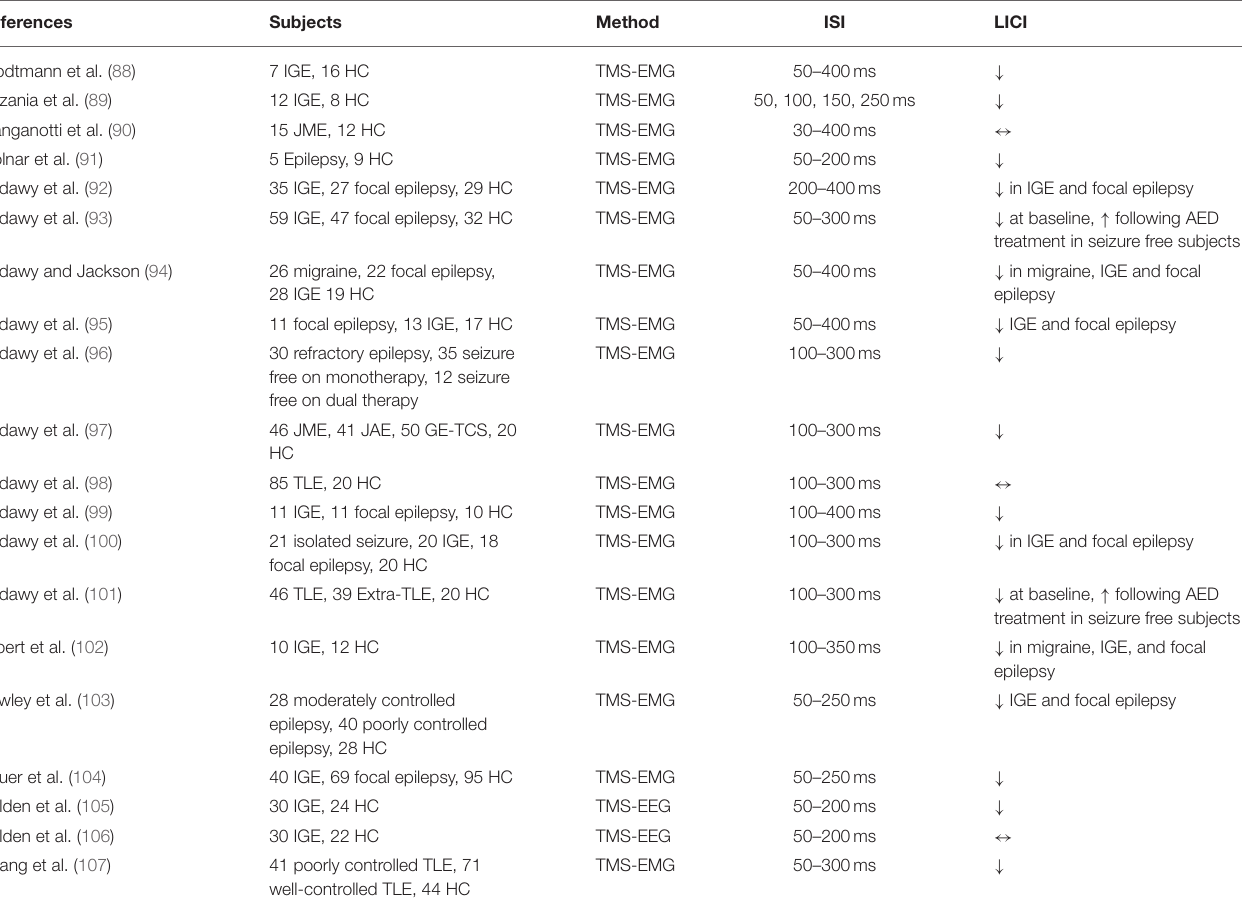
TABLE 9 | LICI in patients with